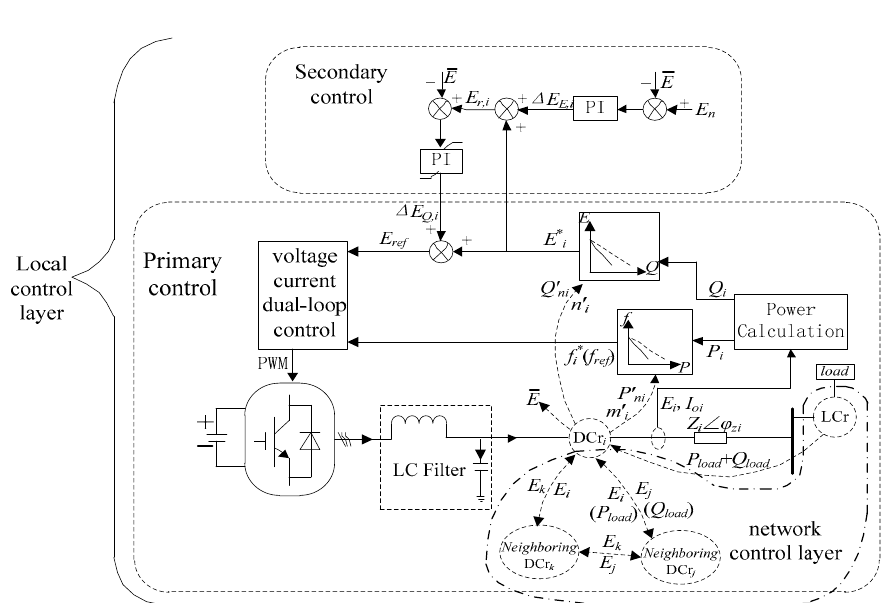
Figure 4. Distributed sparse communication network.